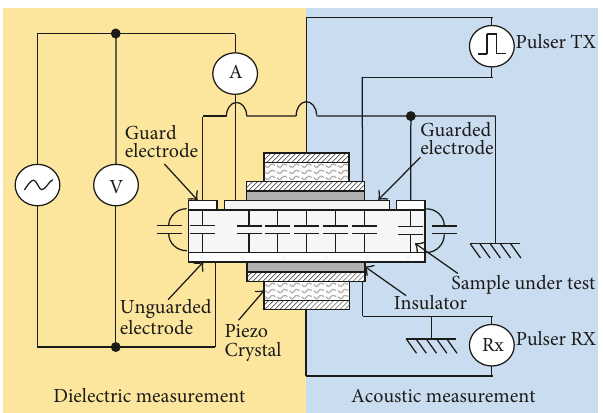
Figure 4: Principal scheme of the parallel plate measurement setup, modified from Josh